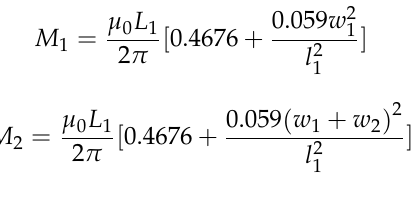
Figure 2. Geometry of the SRRs coupled with the microstrip line ( a ). Photograph of the embroidered prototype ( b ).